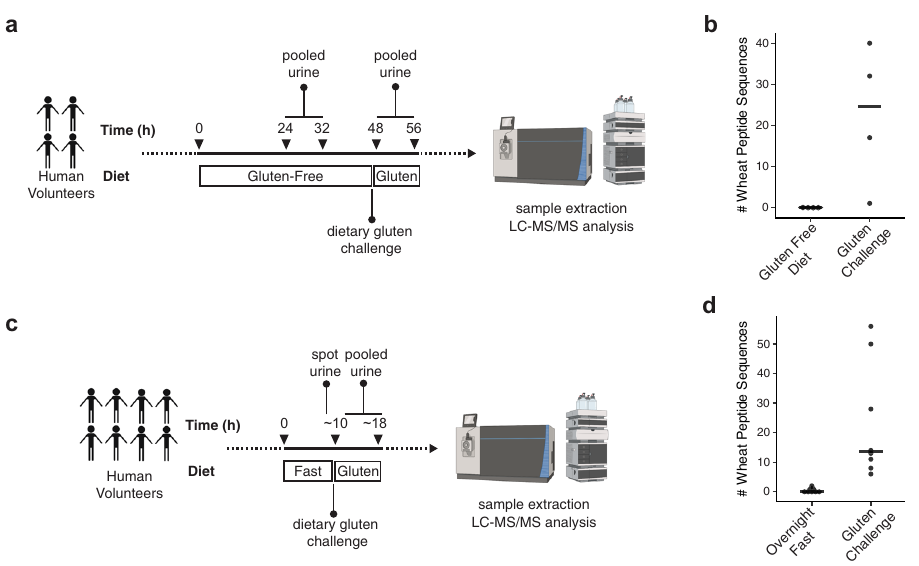
Fig. 2 LC – MS/MS enables the identi fi cation of chemically de fi ned dietary wheat peptides in human urine. a Pilot study design. b Number of wheat- derived peptide sequences detected in the urine of 4 healthy participants (4 males, 24-28 years of age) after a 24-h gluten-free diet and after a dietary challenge with wheat gluten. Horizontal line represents median. c Simpli fi ed study design. d Number of wheat-derived peptide sequences detected in 8 healthy participants (5 males, 3 females, 24-28 years of age) after an overnight fast and after a dietary challenge with wheat gluten. Horizontal line represents median. In all LC – MS/MS experiments, peptide identi fi cations were controlled at a false discovery rate of 1% using the PEAKS software decoy- fusion approach 59 . Source data are provided as a Source Data fi